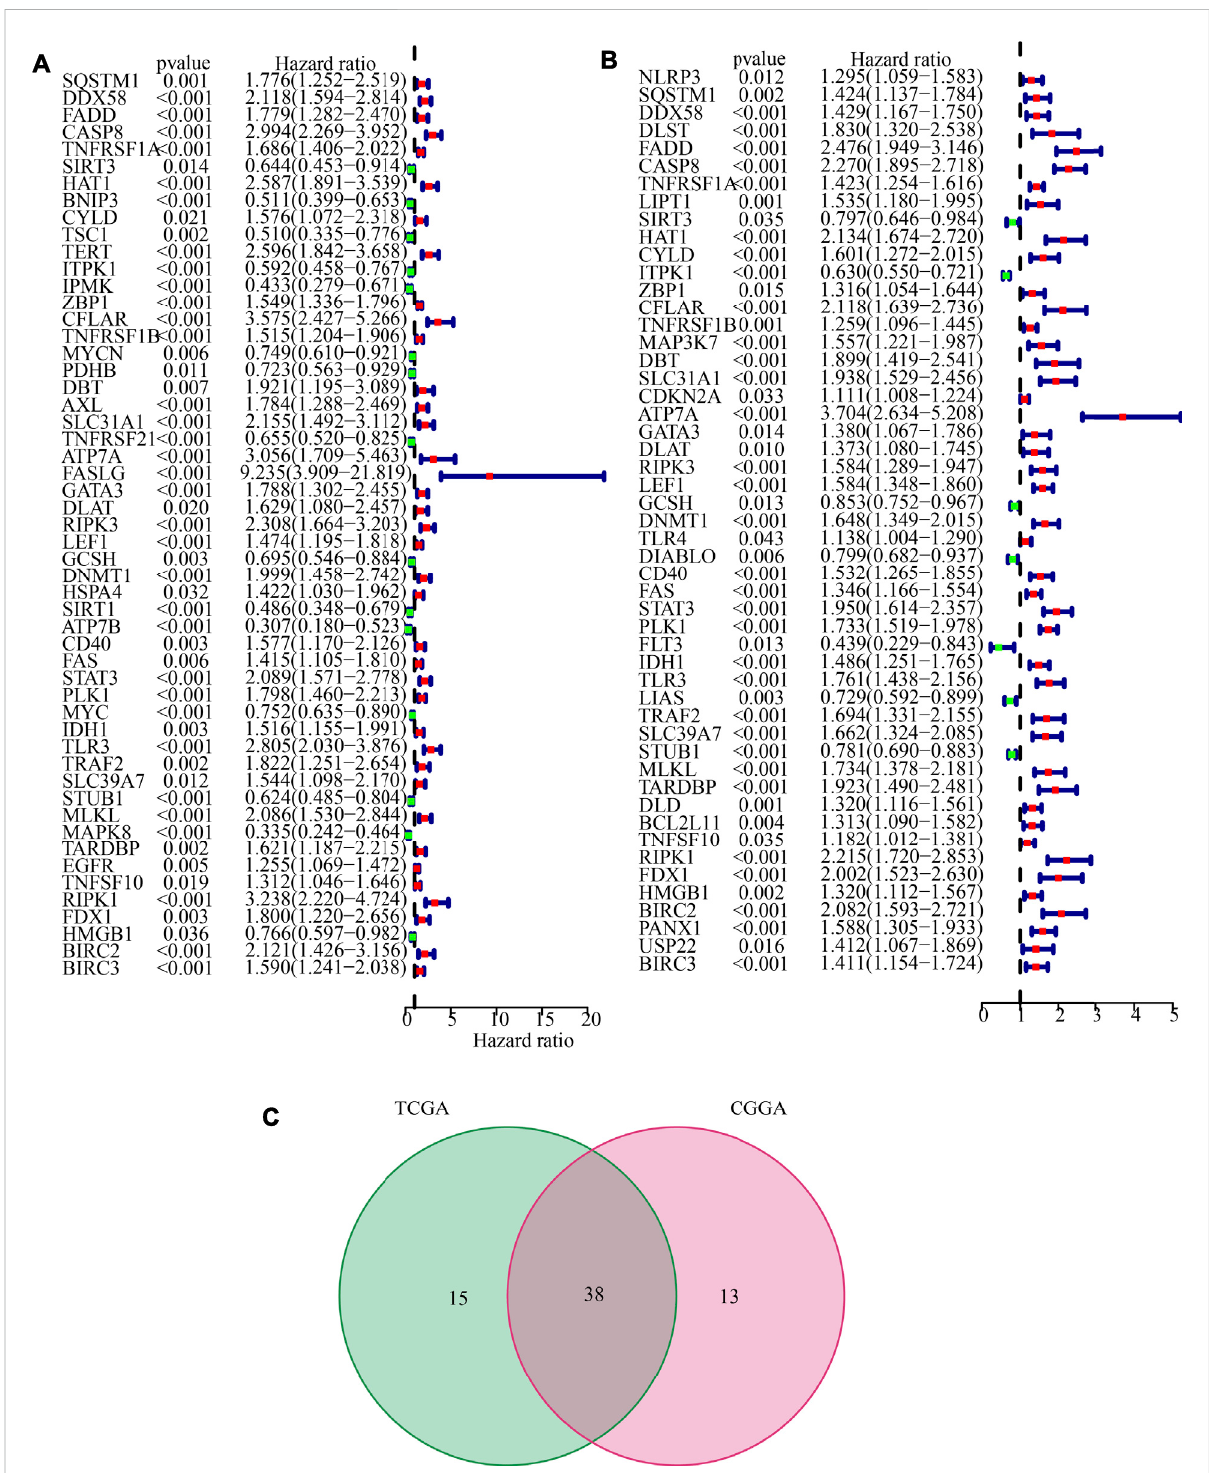
FIGURE 3 Identi fi cation of prognostic cuproptosis and necroptosis-related genes (CNRGs). (A) 53 CNRGs with prognostic values in TCGA dataset. (B) 51 CNRGs with prognostic values in the CGGA dataset. (C) Venn diagram to identify 38 FPRGs with prognostic values in